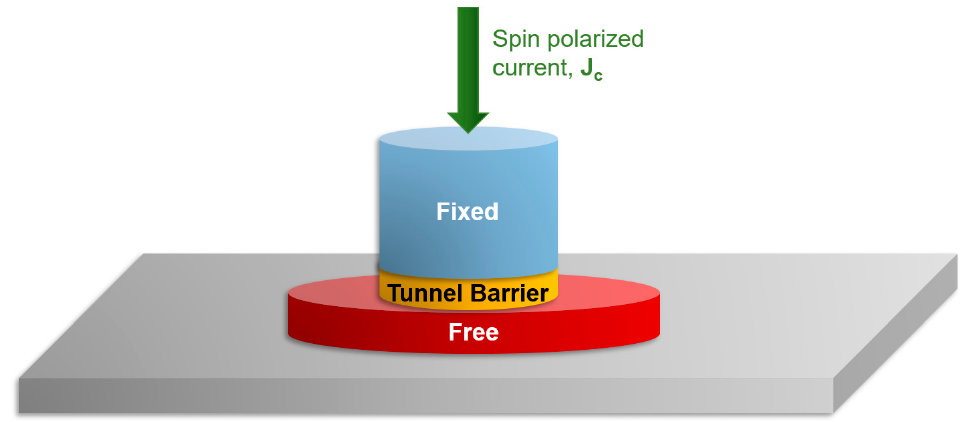
Figure 9. Simulation geometry for skyrmion injection in nano-disks as free magnetic electrodes of magnetic tunnel junction devices.